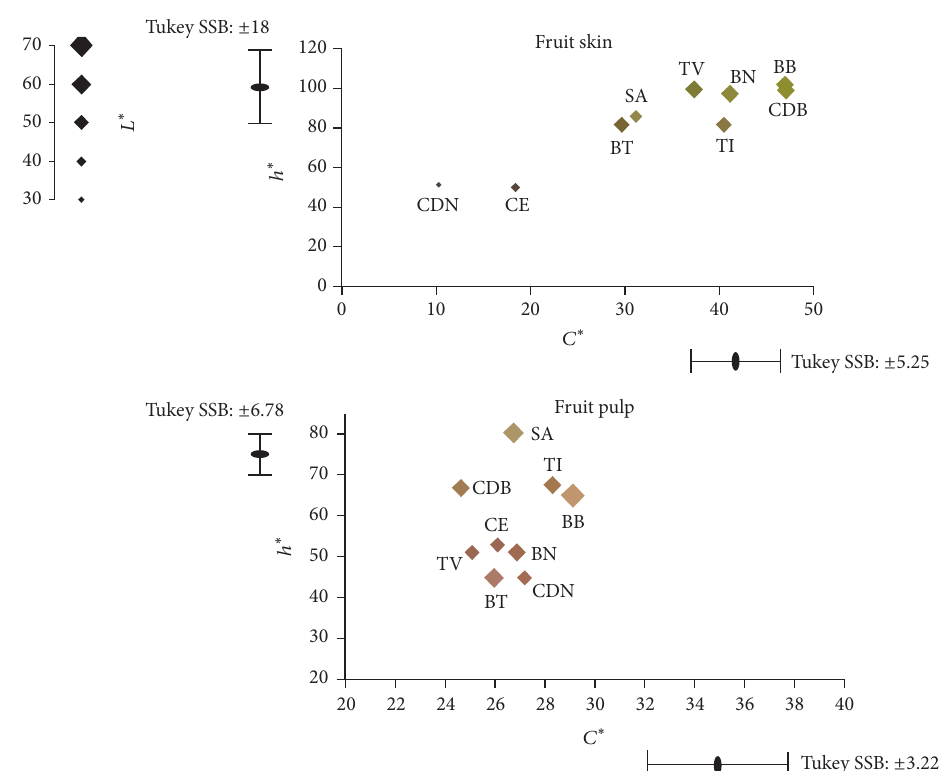
Figure 2: Values of color parameters ( 𝐿 ∗ , 𝐶 ∗ , and ℎ ∗ ) for skin and flesh of the ten varieties of brebas studied. CDB: Cuello Dama Blanco; BT: Brown Turkey; Ti: Tiberio; SA: San Antonio; CDN: Cuello Dama Negro; BN: Banane; CE: Colar Elche; TV: Tres Voltas L’Any; BB: